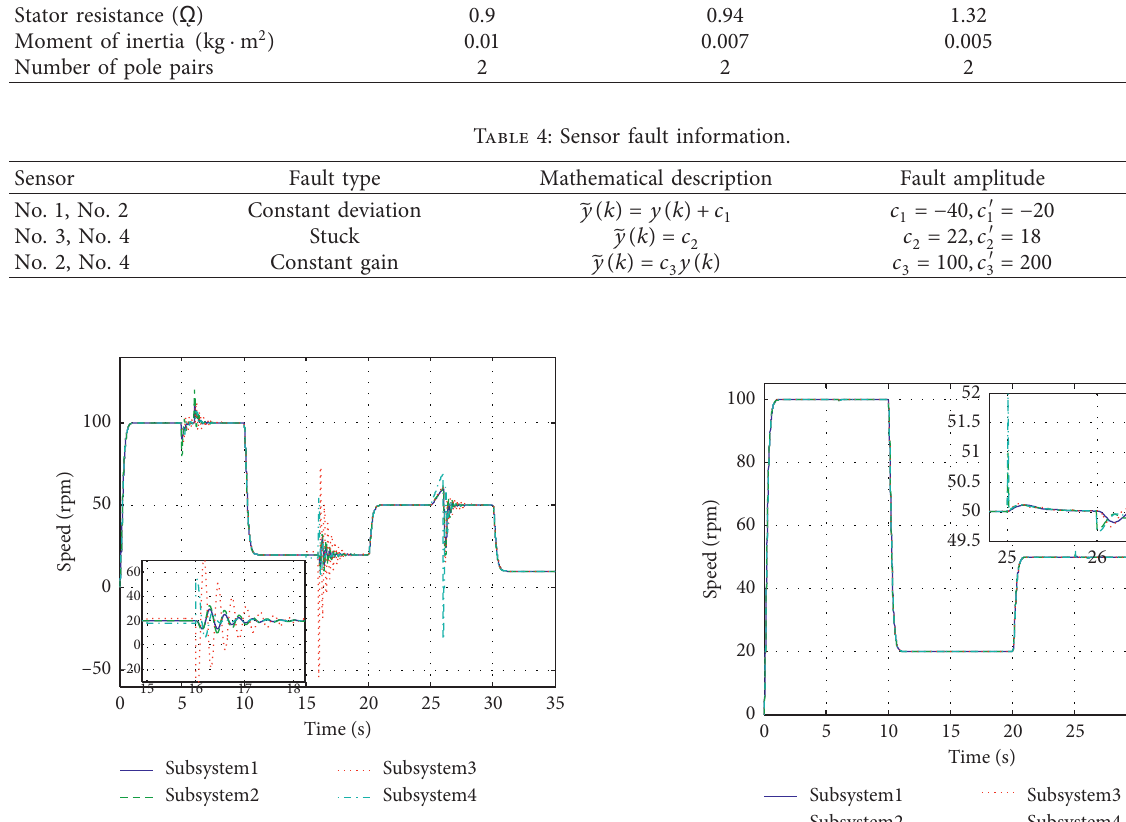
Figure 8: Synchronous output without taking any action when two sensors fail simultaneously.